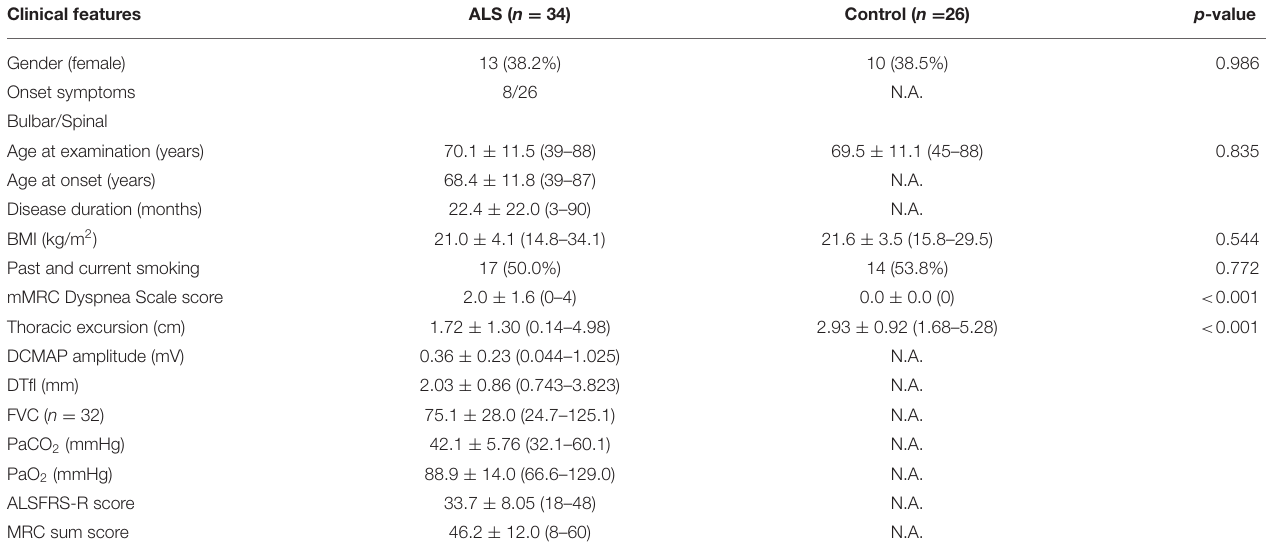
TABLE 1 | Demographic characteristics of patients with ALS and control